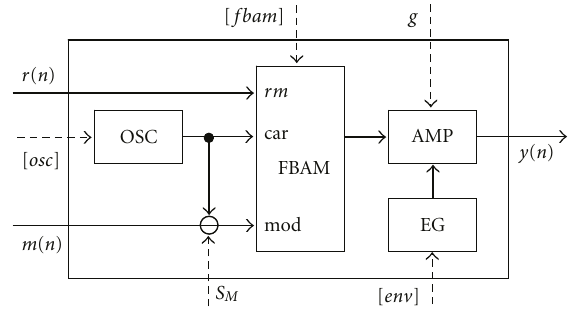
Figure 19: FBAM operator, interfaced by audio rate signals (solid) and control rate parameters (dashed). Table 2: Computational load of FBAM, its variations, and related synthesis